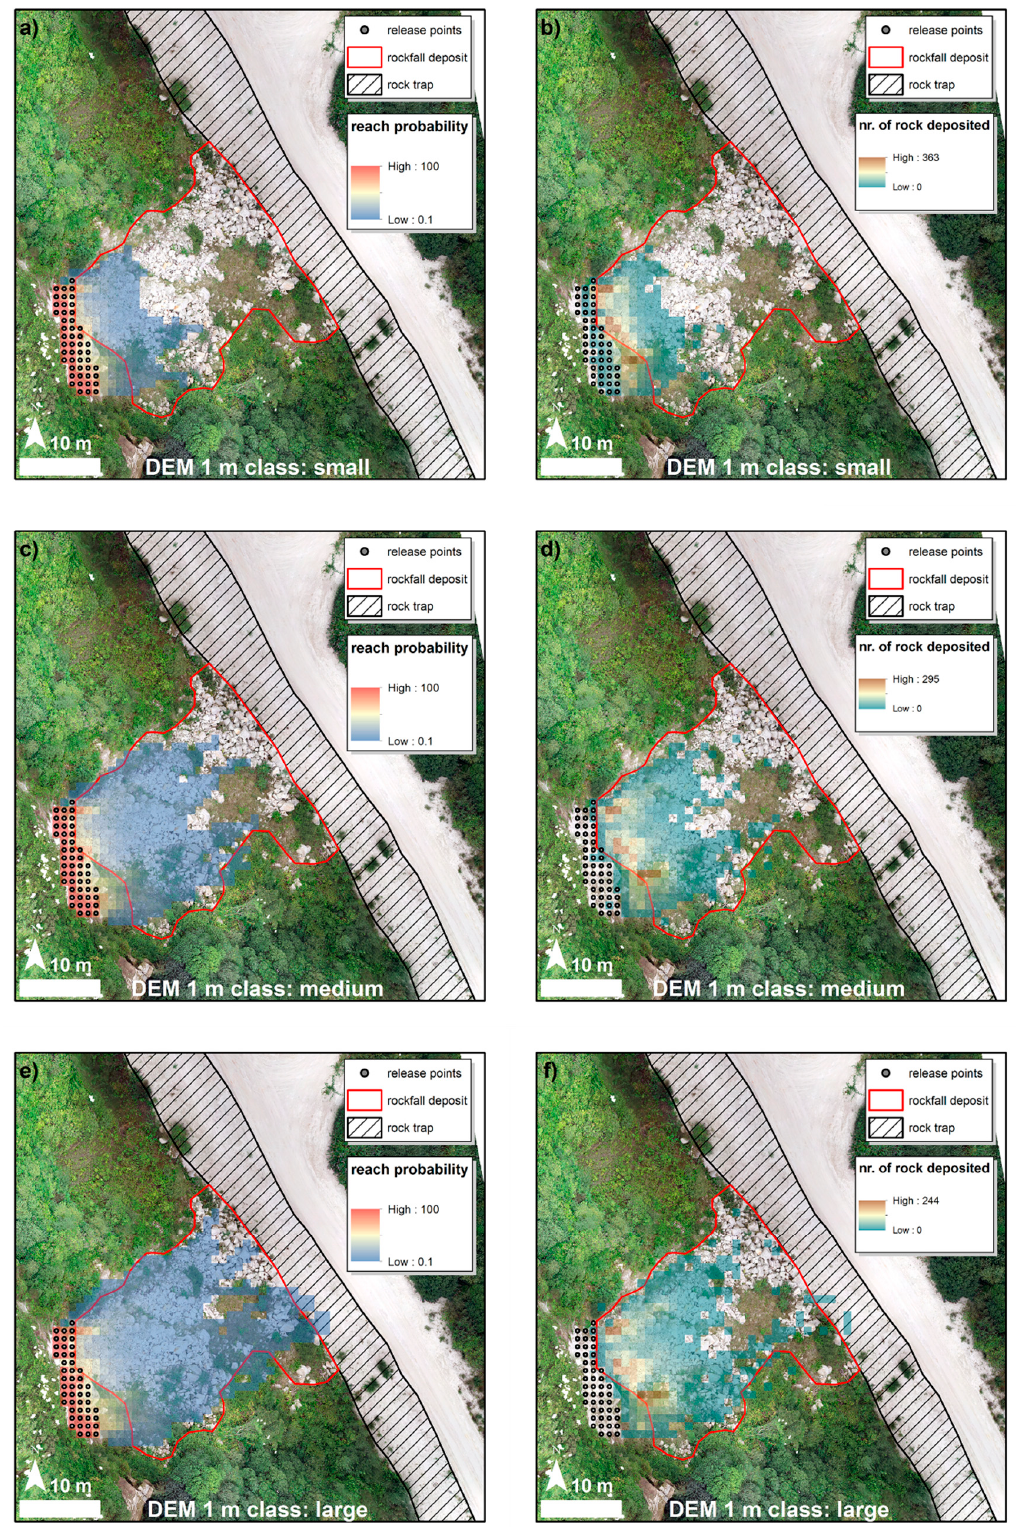
Figure 12. Rockyfor3D results computed on the 1 m resolution DEM. Left hand images ( a , c , e ) show the reach probability layers, on the right ( b , d , f ) the number of rocks deposited. The first row shows ( a , b ) results obtained with the rock class ‘SMALL’, second row ( c , d ) with ‘MEDIUM’ and the third row ( e , f ) with ‘LARGE’. Rock block classes’ properties are summarised in Table 5.